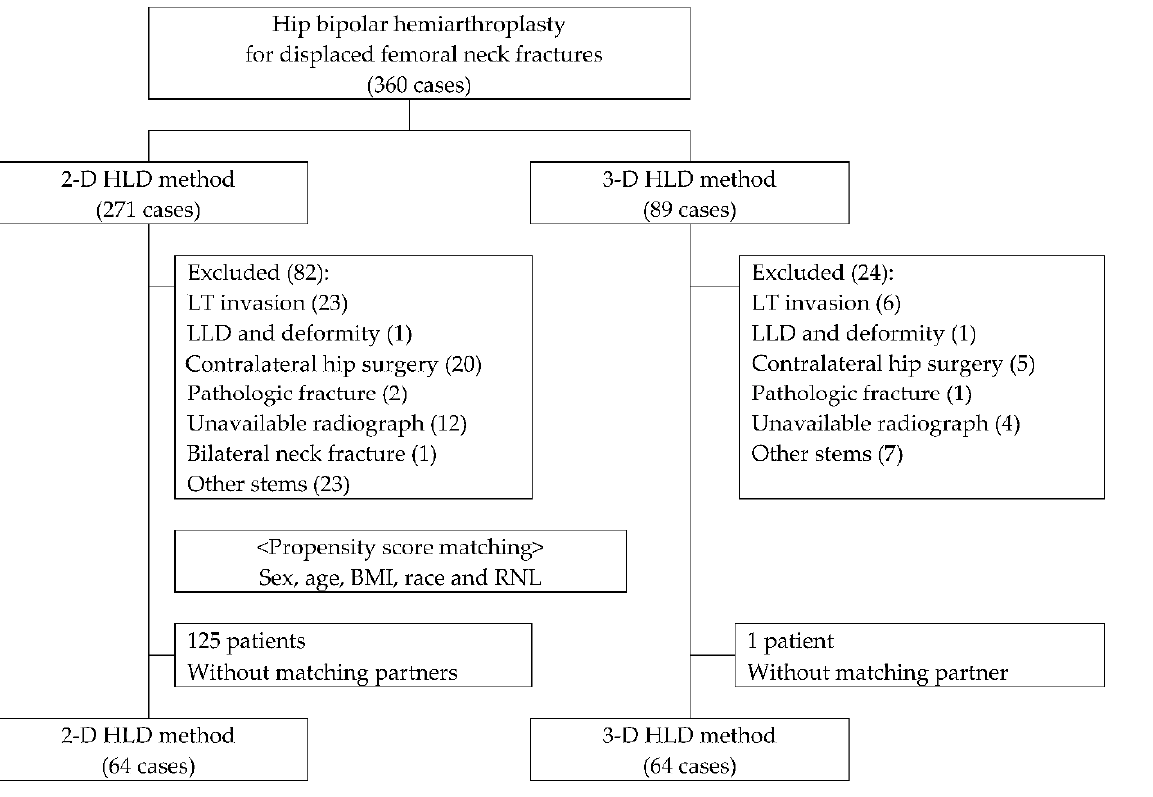
Figure 2. Classification of patients. HLD: head-lesser trochanter distance, LT: lesser trochanter, LLD: limb length discrepancy, BMI: body mass index, RNL: relative neck length. LLD: limb length discrepancy, BMI: body mass index, RNL: relative neck